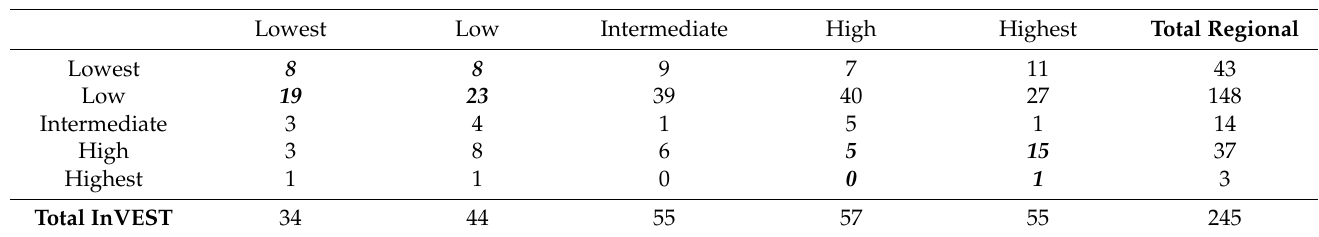
Table 4. Validation of InVEST model results against coastal risk appraisals provided by the Regional Administration. Values in bold italics represent the shore points that are classified in the same way by the two methods considered as being at lowest, low, high and highest